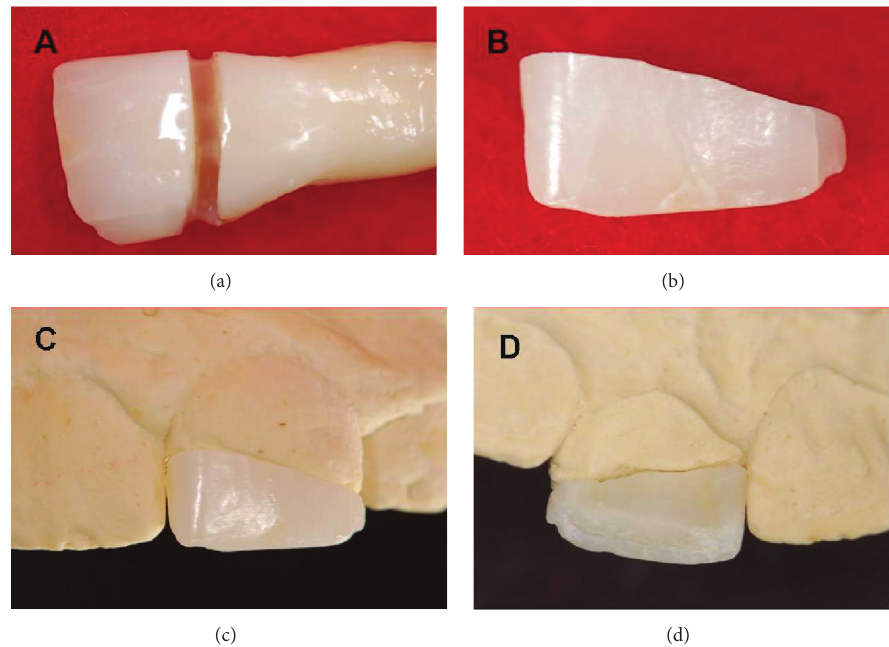
Figure 4: (a) Cut of the dental element to obtain the restorative fragment. (b) Cut of dental fragment. (c) Adaptation of the fragment to the plaster model, vestibular view. (d) Adaptation of the fragment to the plaster model, palatal view.